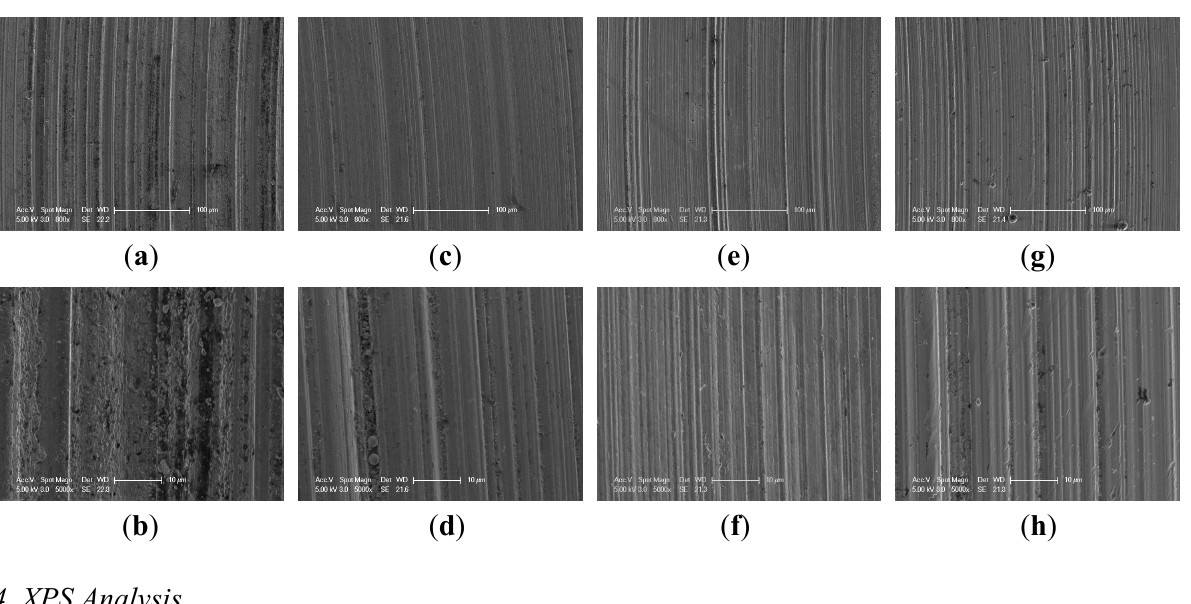
Figure 2. SEM images of the worn surface lubricated with the EO10 ( a , b ), EO30 ( c , d ), EO50 ( e , f ) and BO ( g , h ) under 392